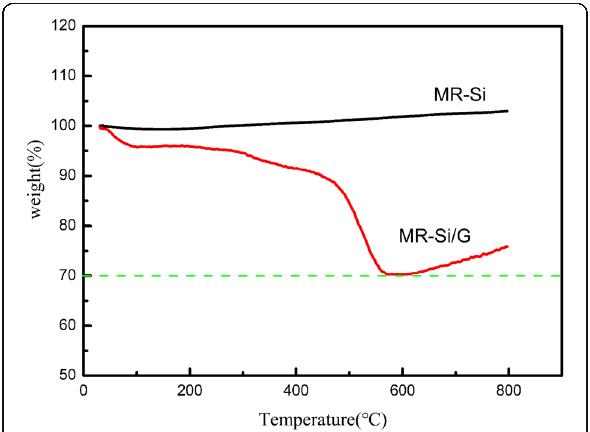
Fig. 6 TGA curves of MR-Si/G composite and pure